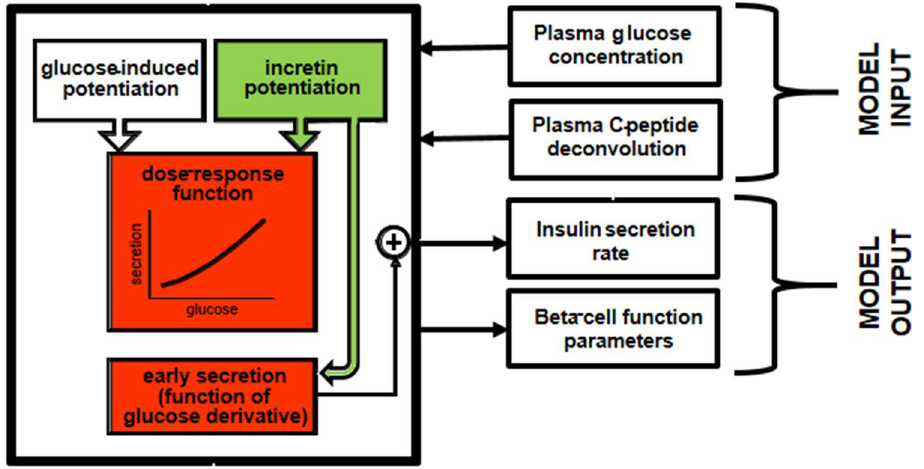
Figure 2. Schematic diagram of the model by Tura et al. [25] for the assessment of the incretin effect on insulin secretion and beta-cell function from an OGTT and an isoglycemic intravenous glucose infusion. The parts of the model related to the effects of incretin hormones are in a green color, whereas the parts affected by such effects are in red.